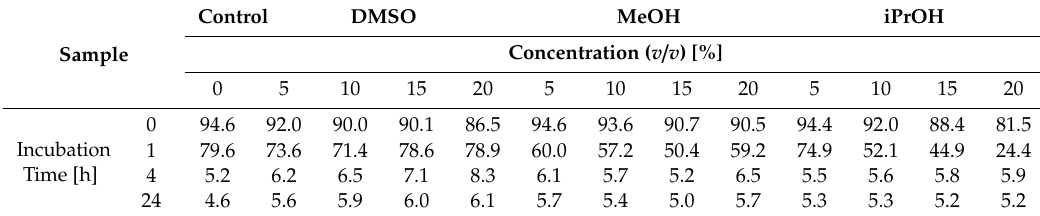
Table 3. The percentage vaterite content (X V ) depending on the incubation time and the concentration of selected